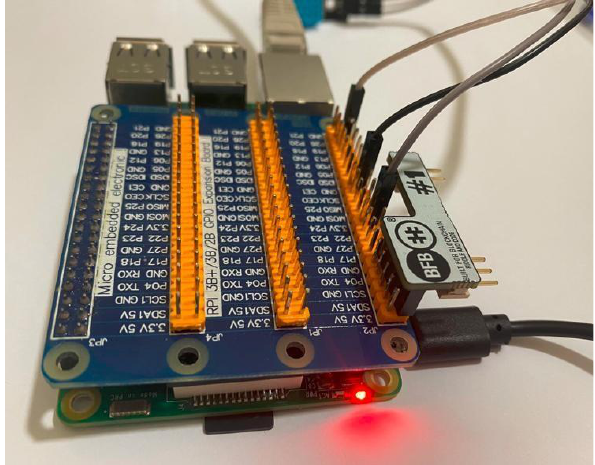
Figure 9. Hardware